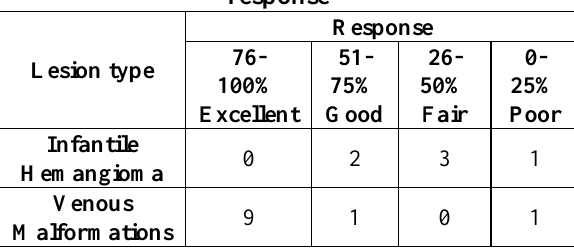
Table 3: Relation between lesion type